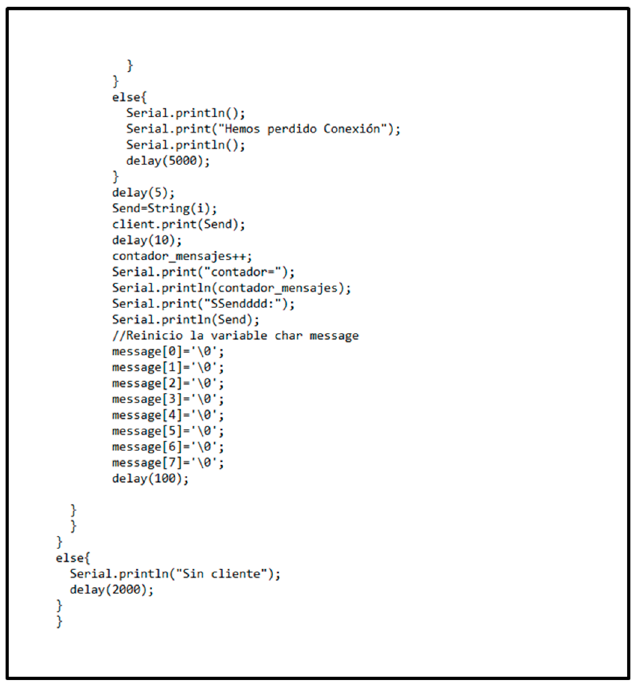
Figure A5. Arduino programming for embedded Wi-Fi, part 2 of 2 .